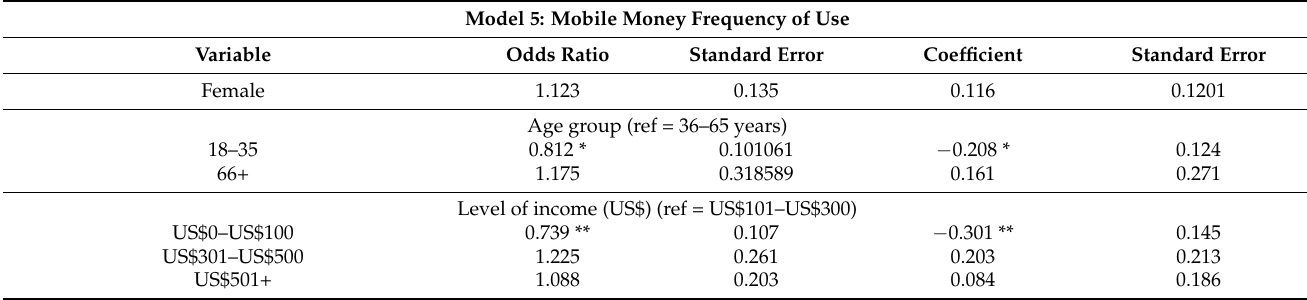
Table 5. Factors associated with frequency of use of mobile money. Model 5: Mobile Money Frequency of